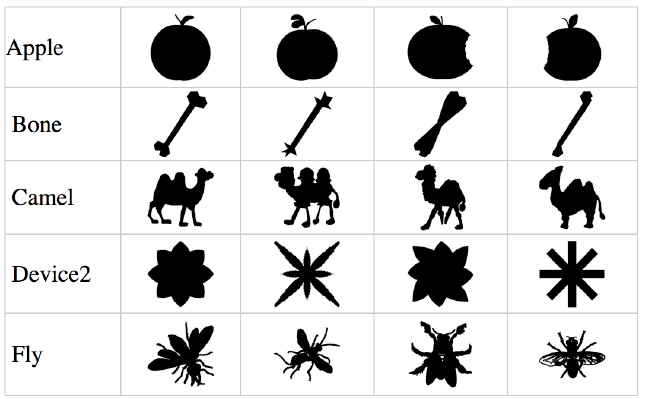
Figure 11. Four sample shapes from five of the classes of the MPEG-7 CE-Shape-1